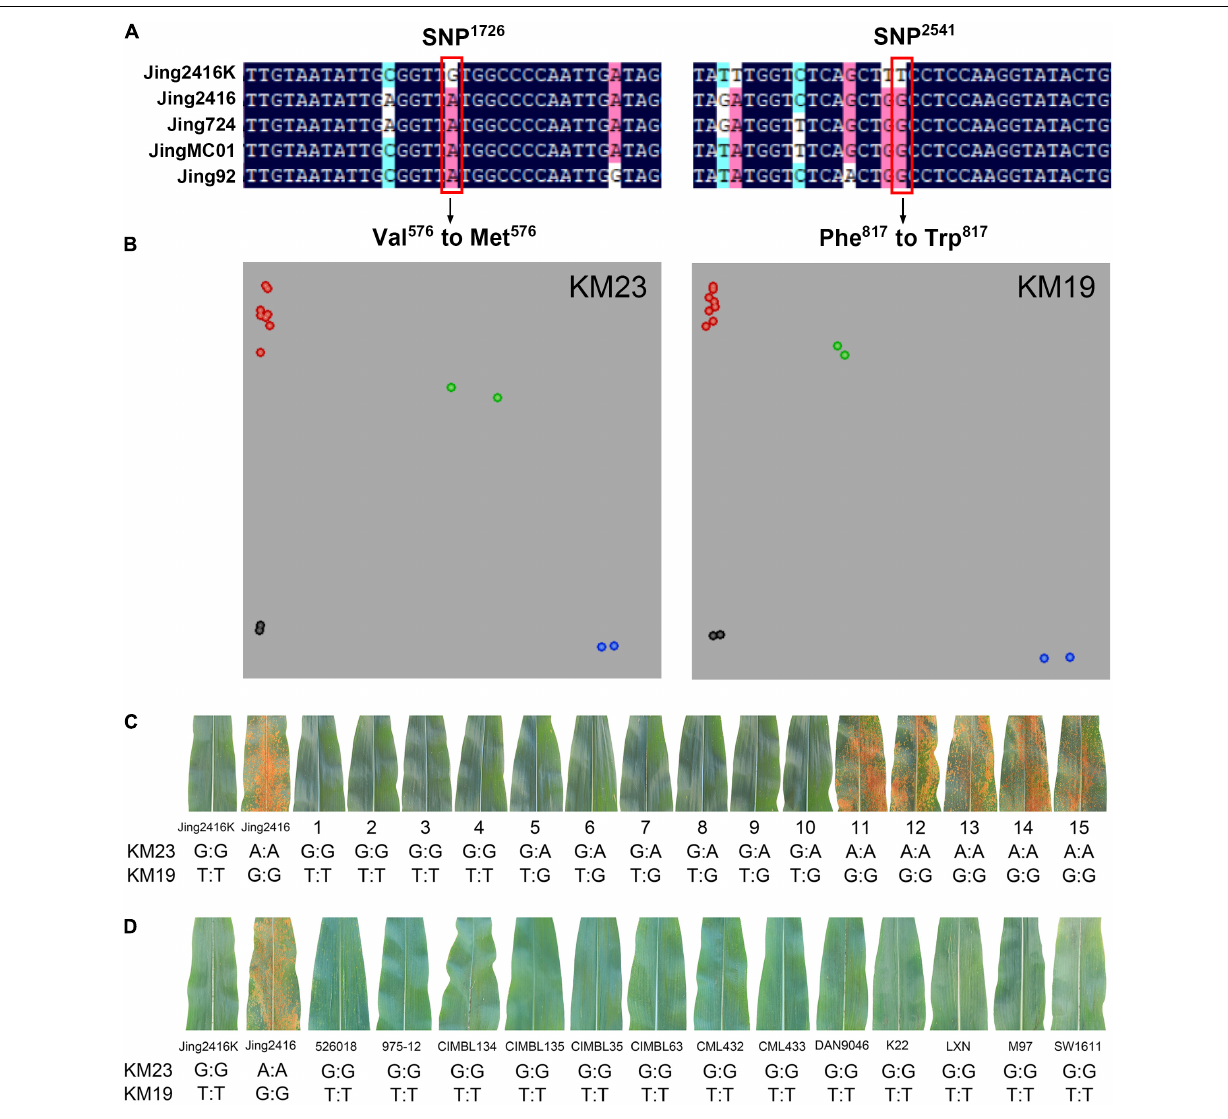
FIGURE 5 | Development of Kompetitive allele-specific PCR (KASP) markers for RppM and genotype analysis. (A) The two conserved SNPs and changes of amino acids in resistant and susceptible lines. SNP sites are indicated by red boxes. (B) Genotyping of inbred lines Jing2416K, Jing2416, Jing724, JingMC01, and Jing92 and F 1 plants of Jing2416 and Jing2416K with markers KM23 and KM19. Red, green, and blue dots represent susceptible, heterozygous resistant, and homozygous resistant genotypes, respectively. Black dots represent the non-template control (NTC). (C) Genotypes of F 2 plants derived from Jing2416 and Jing2416K. 1–10, resistant plants; 11–15, susceptible plants. (D) Thirteen inbred lines of a GWAS population identified with markers KM23 and KM19, all exhibiting SCR